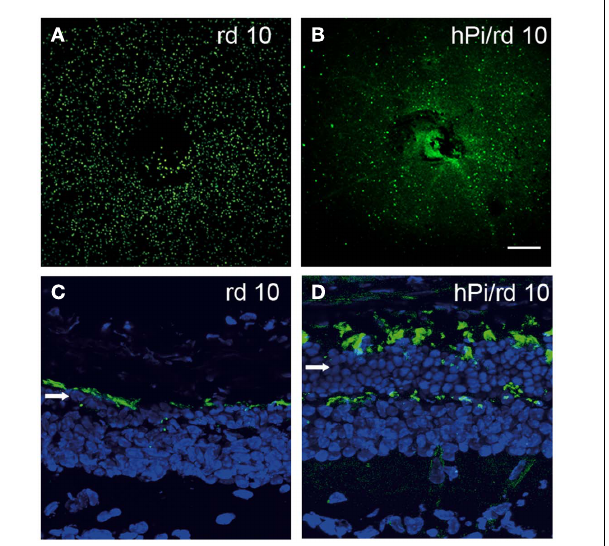
FIGURE 4 | Interference with the insulin receptor increases cell death and decreases the number of retinal ganglion cell neurons in the embryonic chick retina. E2 chick embryos were treated in vivo with control or anti-insulin receptor antibodies.TUNEL-positive cells [in green (A,B) ] were visualized in E4 flat-mount retinas. Optic fibers were labeled by G4/Ng-CAM immunostaining (in red). Retinal ganglion cells were visualized by Islet 1/2 immunostaining [in green (C,D) ] in E6 retinal sections. Reproduced from Díaz et al. (2000) with permission; ©2000, Company of Biologists. Scale bar = 50 μ m.